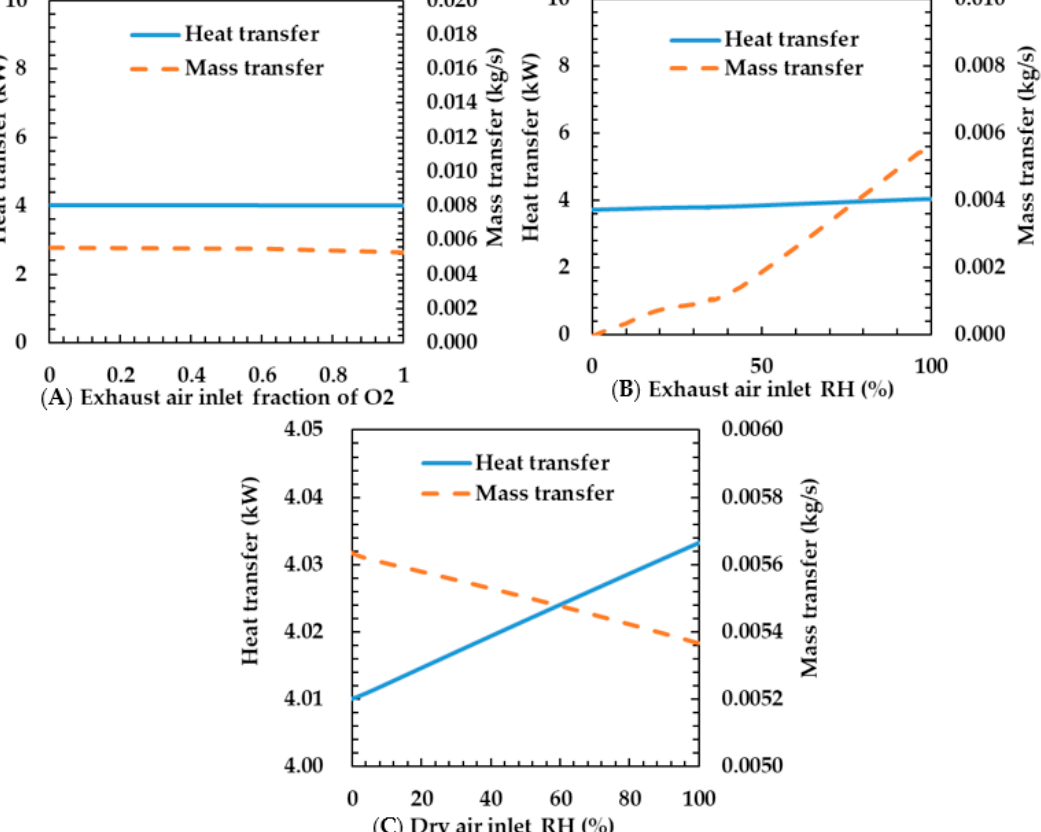
Figure 8. Effects of exhaust air ( A ) and dry air ( B ) temperature on heat and mass transfer rates of the porous metal foam humidifier.